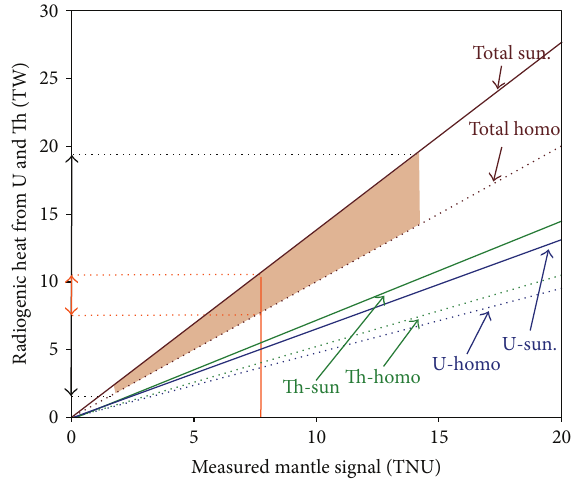
Figure 12: The mantle radiogenic heat power from U and Th as a function of the measured geoneutrino signal; the solid lines represent the sunken-layer model, while the dotted lines the homo- geneous mantle (see Section 4). The green and the blue lines indicate the individual Th and U contributions, respectively, while the brown lines show the total signal. The measured mantle geoneutrino signal 𝑆 SYM from a combined Borexino + KamLAND analysis is shown Mantle by the vertical solid orange line; the corresponding 1 𝜎 band is shown by a filled triangular area. The arrows on the vertical 𝑦 -axis indicate the radiogenic heat corresponding to the best fit geoneutrino signal. Details in